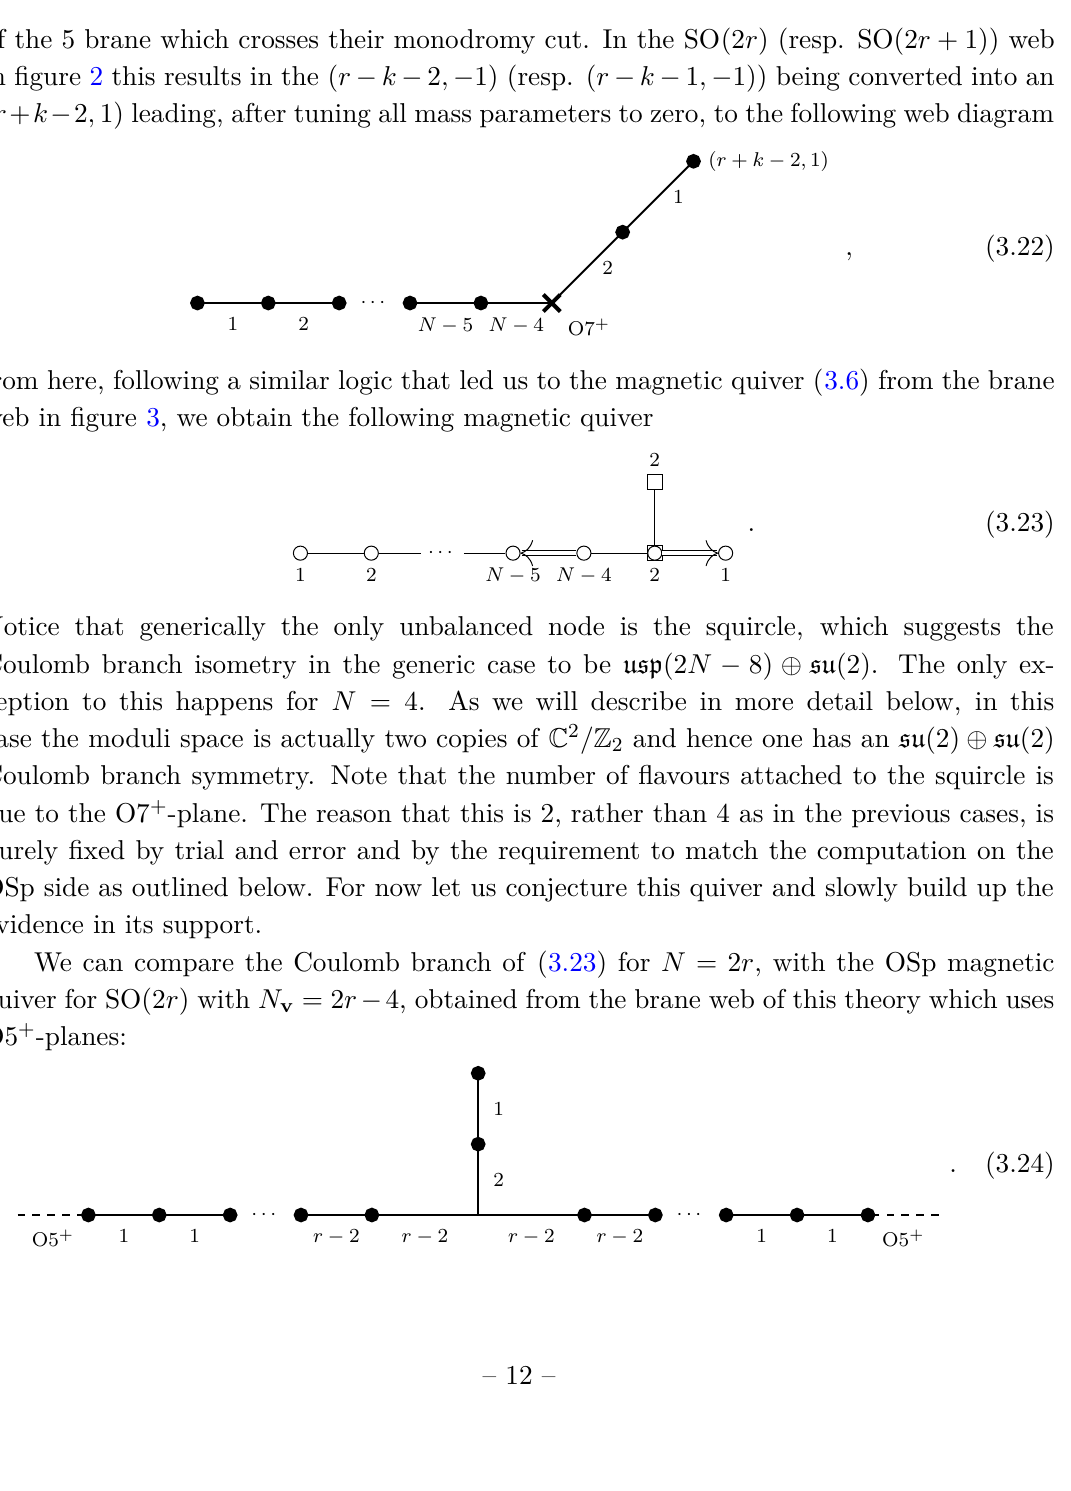
Figure 4 . Brane web for SU(4) 0 +1 AS